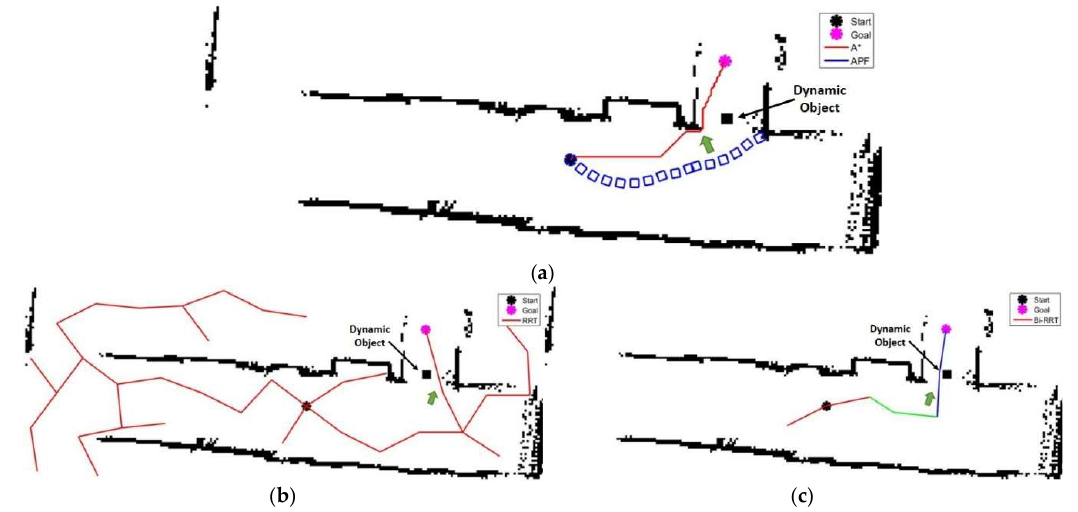
Figure 23. Generated path, for Dataset V, using: ( a ) A* algorithm and APF method; ( b ) RRT algorithm; and ( c ) bidirectional RRT algorithm.